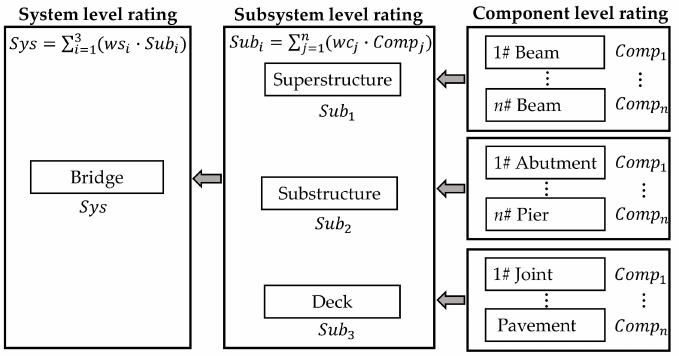
Figure 2. Relationship among component ratings, unit ratings, and system